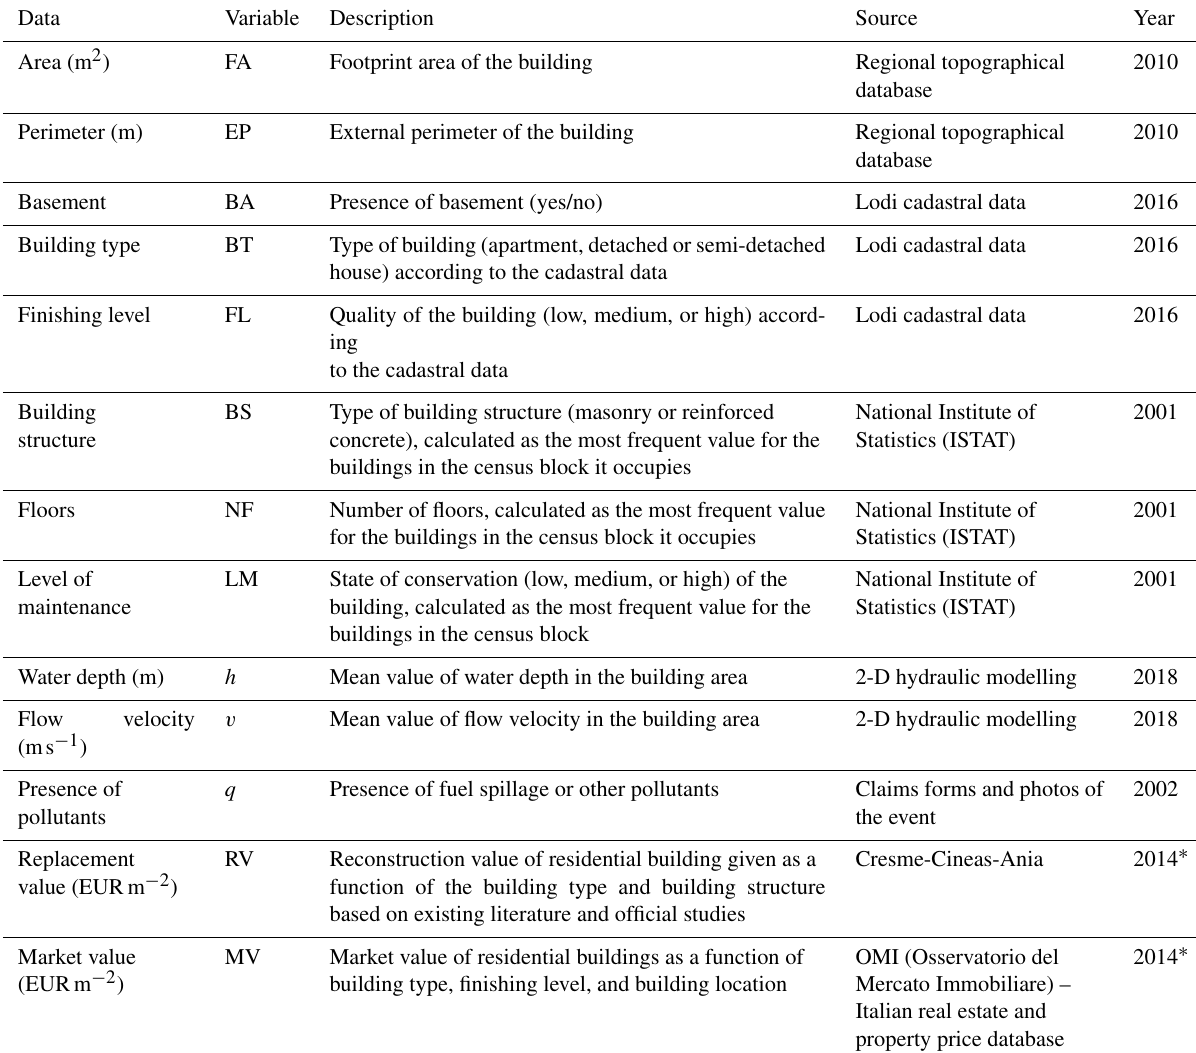
Table 1. Available microscale data for the blind